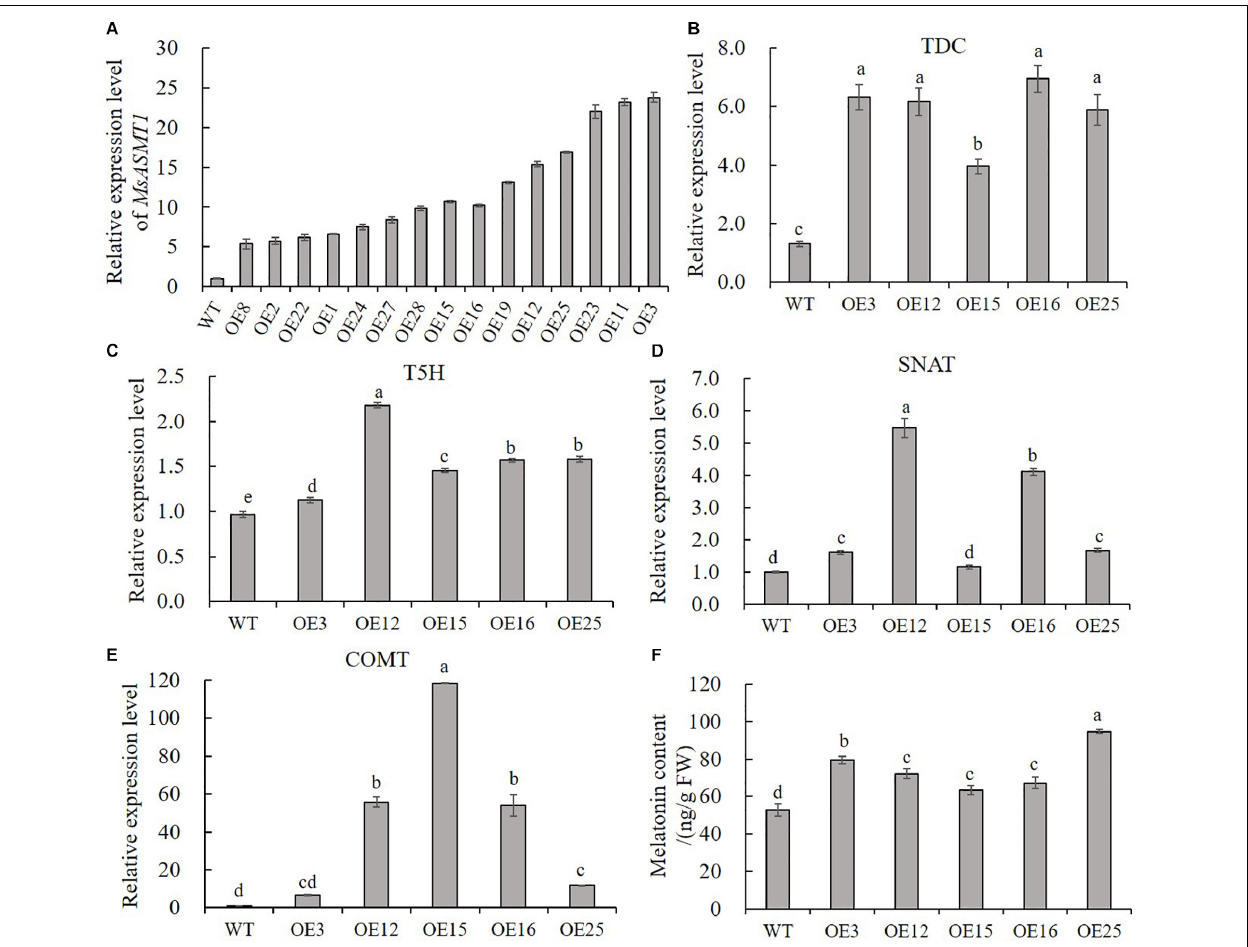
FIGURE 2 | Relative expression level of MsASMT1 and the upstream genes of ASMT in melatonin biosynthesis pathway and the melatonin content in WT plants and OE-MsASMT1 transgenic plants. (A) Relative expression level of MsASMT1 in various transgenic alfalfa plants; (B–E) MsTDC (B) MsT5H (C) MsSNAT (D) and MsCOMT (E) in WT plants and OE-MsASMT1 transgenic plants; (F) Melatonin content in WT plants and OE-MsASMT1 transgenic plants, the correlation between melatonin content and relative expression level of MsASMT1 is analyzed by SPSS with Pearson Correlation Coefficient ( p < 0.05). Data are presented as mean ± SE ( n = 3). The letters indicate the differences between WT and OE-MsASMT1 transgenic plants according to ANOVA analysis ( p <